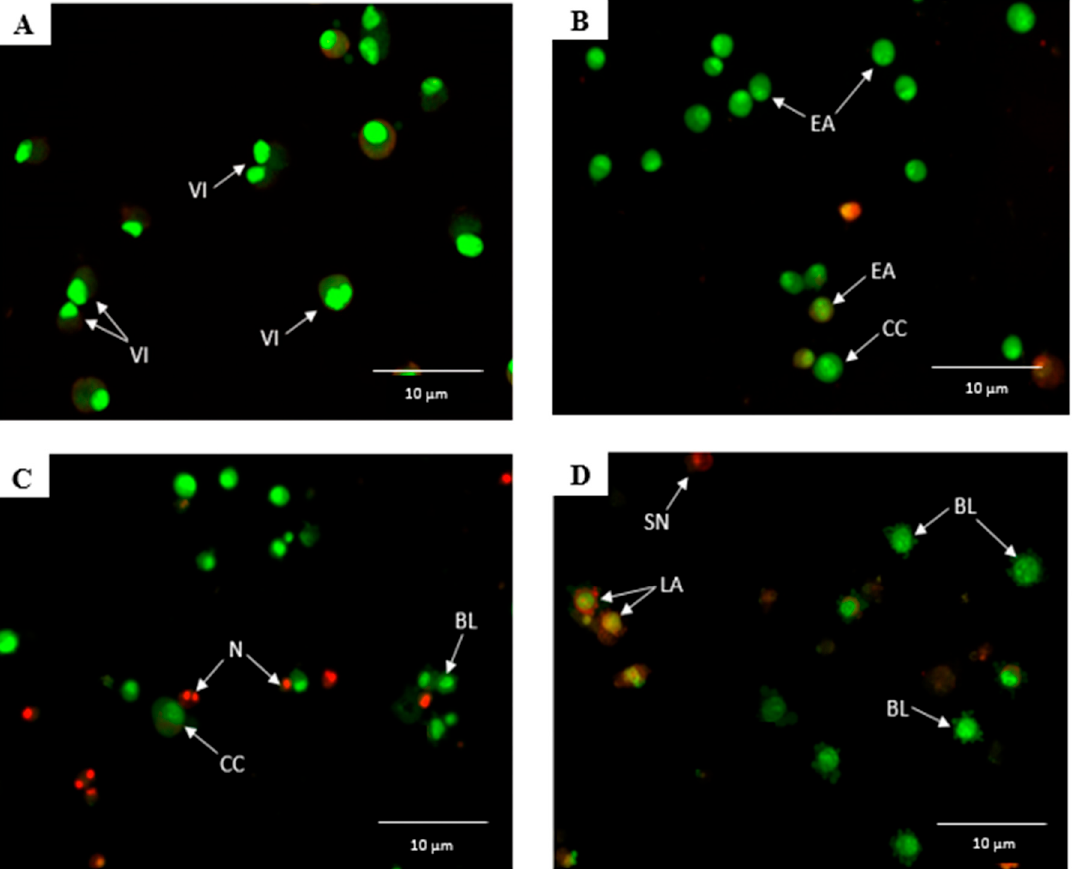
Figure 3. Raphasatin-induced apoptosis in the MCF-7 cells assessed by acridine orange/propidium iodide (AO/PI) staining. MCF-7 cells were treated with 9.84 µM (IC 50 ) concentration of raphasatin, for 24 h ( B ), 48 h ( C ), and 72 h ( D ), and were compared with the untreated cells ( A ). Images represent one of the three independent experiments. Viable cells (VI), early apoptosis (EA), chromatin condensation (CC), blebbing (BL), late apoptosis (LA), necrosis (N), and secondary necrosis (SN).